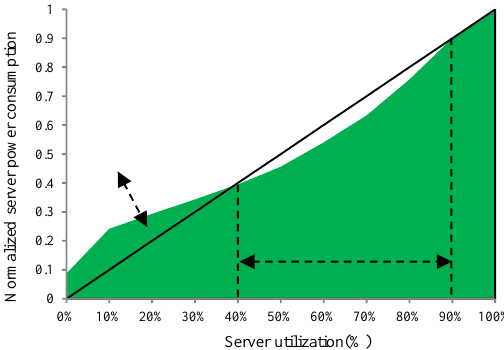
Figure 2. Energy efficiency curve of the server with an EP value of 0.98.